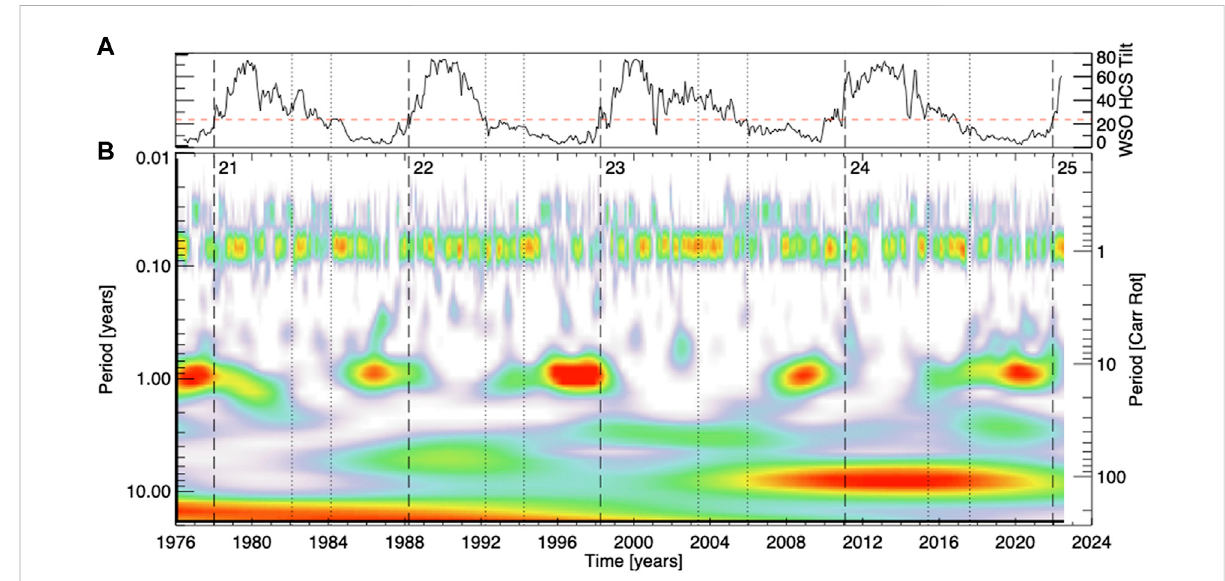
FIGURE 5 (A) ThetiltangleoftheHeliosphericcurrentsheetasmeasuredbytheWSO. (B) Morletwaveletmapoftheinterplanetarymagnetic fi eldpolarity 1976 – 2022showingperiodicities from4 days to22 years. As inFigures 2, 3,thevertical dashed linesshown ineach panel mark thetimes of theHale Cycle termination events studied byM2019; thedotted vertical lines correspond to 0.4 and 0.6 of thecycles ’ duration from terminator to terminator ( cf. Leamon et al., 1969). The dashed horizontal line in the HCS tilt panel is drawn at 23.4 ° ; exceeding this value is a reasonable scalar proxy for the Hale Cycle